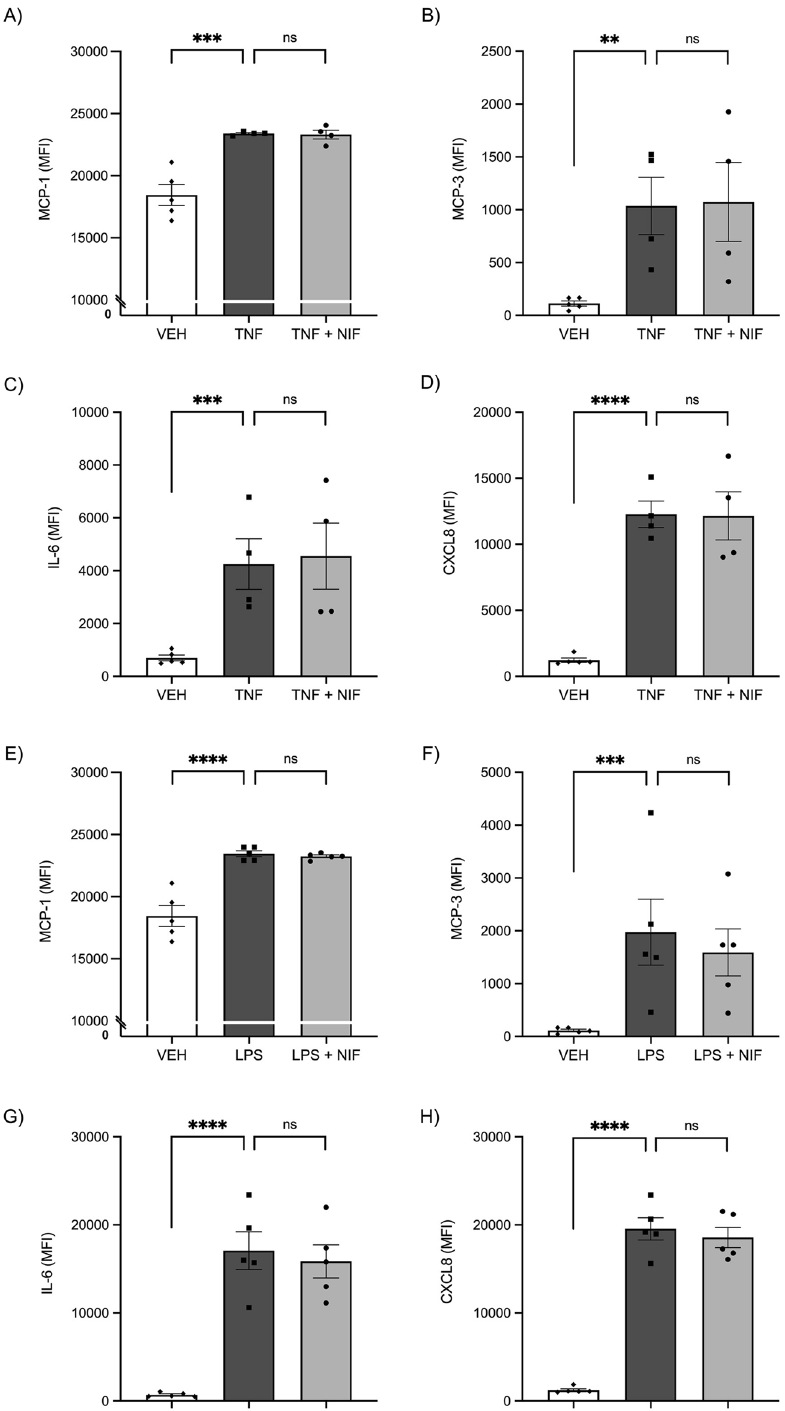
Figure 4. Pro-inflammatory cytokines and chemokines secreted by human myometrial cells were assessed in media collected after treatment with vehicle control (VEH), TNF, LPS, and nifedipine (NIF). Treatment of myometrial cells with ( A–D ) TNF (0.1 ng/ml) and ( E–H ) LPS (100 ng/ml) induces a significant increase in production and release into culture media of pro-inflammatory cytokines and chemokines MCP-1, MCP-3, IL-6, and CXCL8 and co-treatment with nifedipine (10 µM) does not reduce this increased expression. Data is expressed as the median fluorescence intensity of technical replicates as measured by Luminex assay. Statistical analysis was performed on the log2 transformation of the fluorescence intensity using an ANOVA followed by Tukey’s multiple comparisons. Treatments were performed in duplicate and individual data points represent the mean of those technical replicates ( n = 4 experiments). The error bars represent SEM, ** indicates P < 0.01, *** indicates P < 0.001, **** indicates P < 0.0001, and ns indicates no statistical